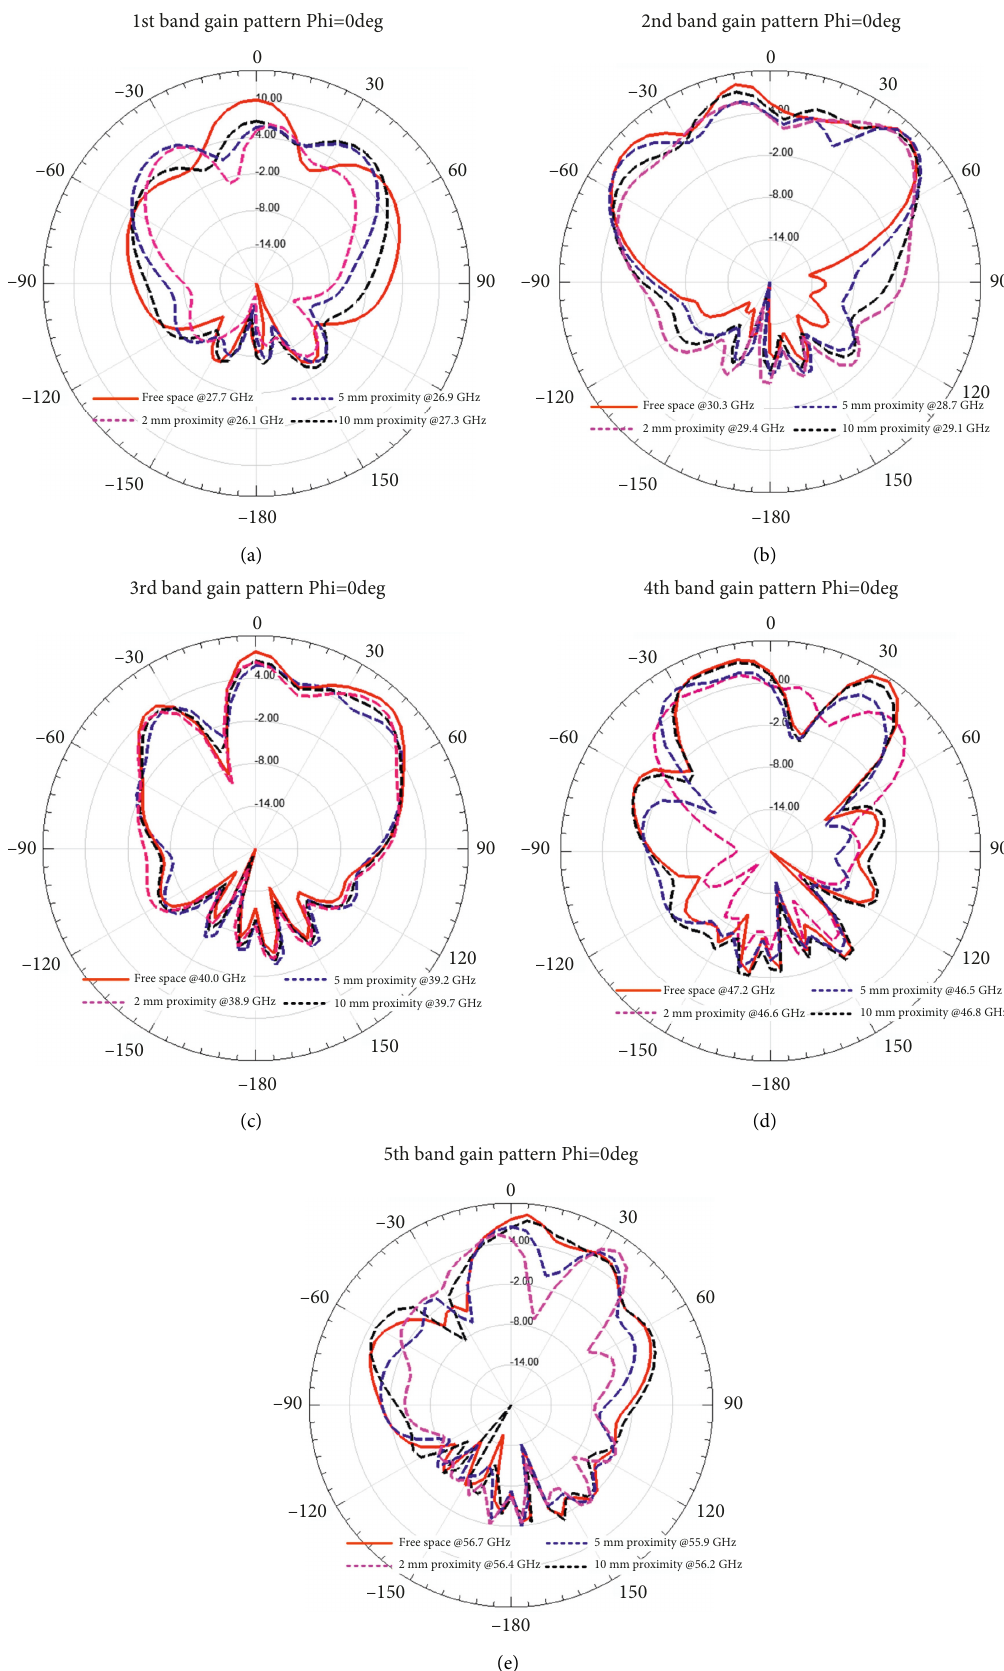
Figure 13: E-plane pattern of optimized antenna at various distances from human body